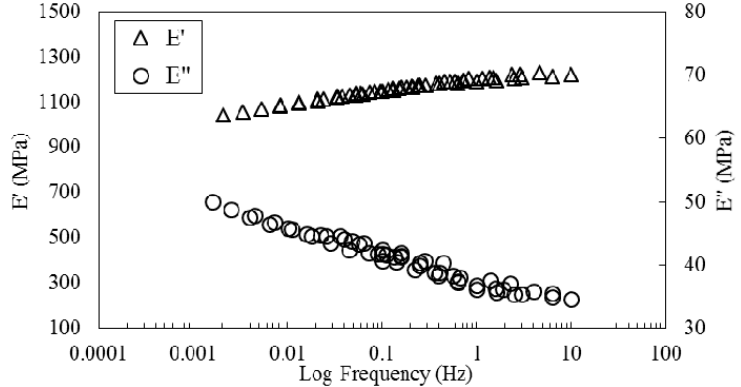
Figure 8. Master curves obtained by horizontal and vertical shifting of the frequency sweeps.